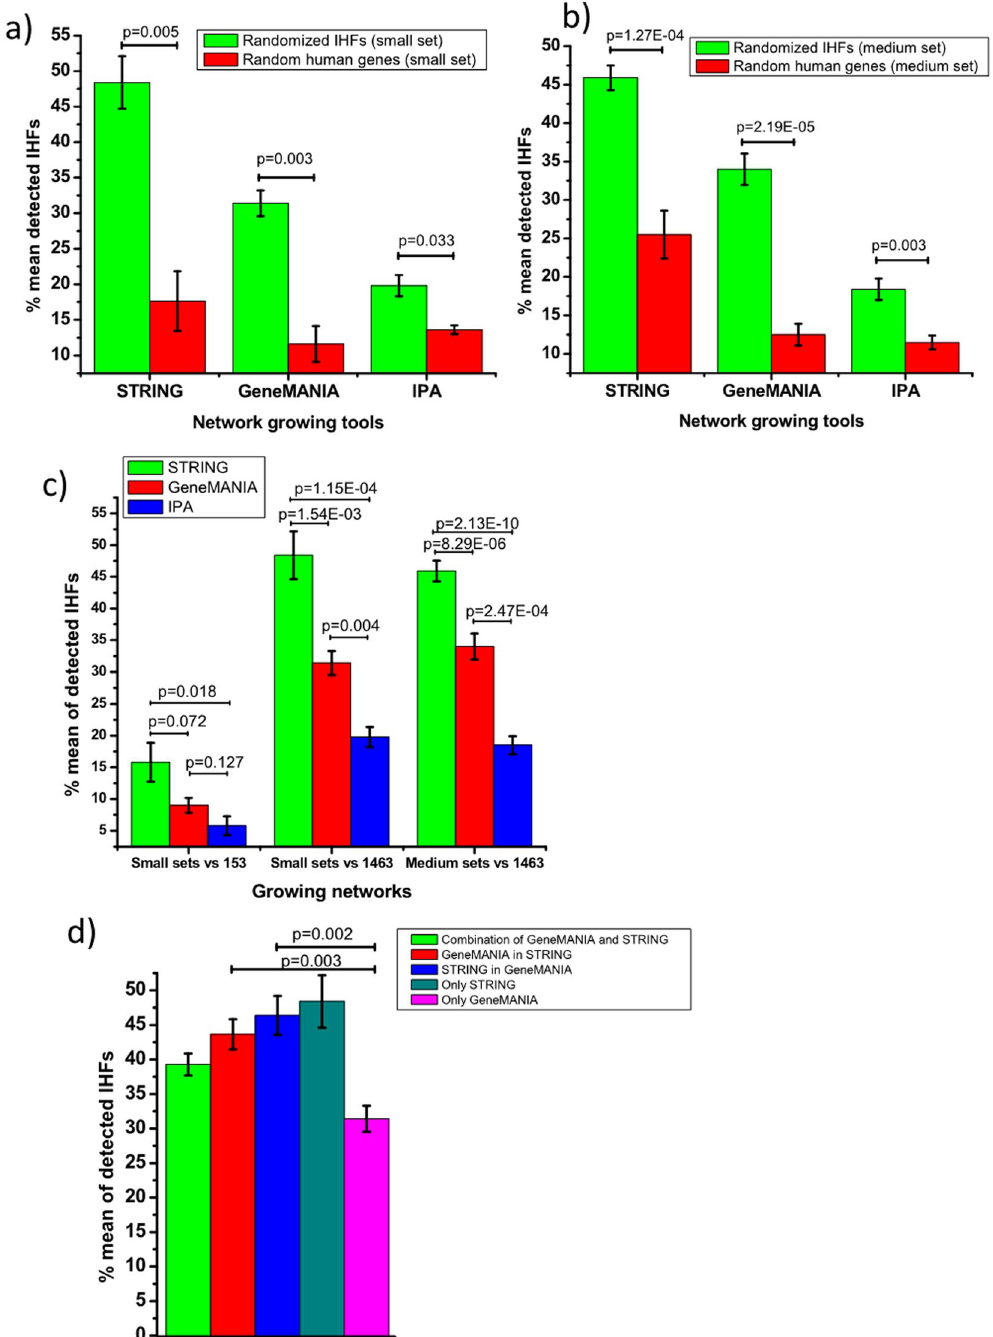
Figure 2. Detection rate of network growing tools after randomization of IHFs and random human proteins. ( a ) Comparison of the detection performance of the network growing tools after growing 100 genes using either small set (30 genes) IHFs or random human proteins as seeds and 1463 IHFs as positive sets. P-values are the result of a paired Student-t test analysis. ( b ) Comparison of the detection performance of the network growing tools after growing 100 genes using either medium set (146 genes) IHFs or random human proteins as seeds and 1463 IHFs as positive sets. P-values are the result of a paired Student-t test analysis. ( c ) Detection performance comparison of the three network growing tools ( d ) The detection rate of STRING and GeneMANIA after combination and interchange of the 1 st 50 grown